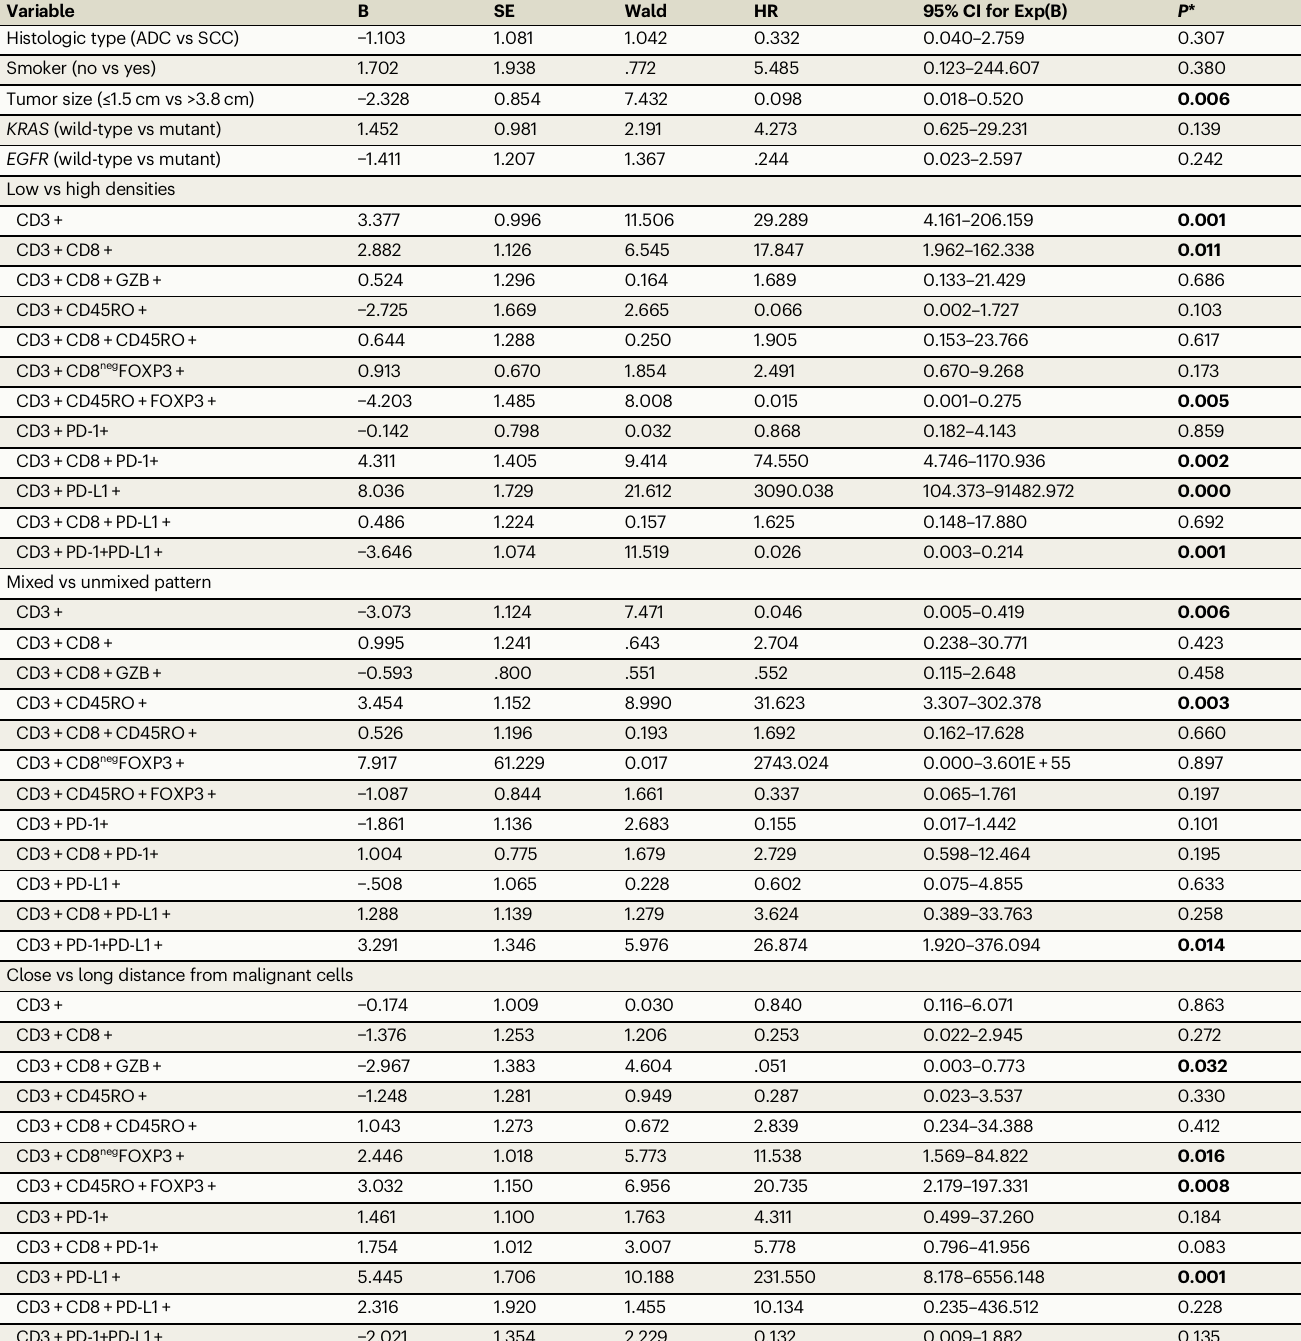
Table 4 | Cox proportional hazards regression model of overall survival in patients with non-small cell lung cancer compared high and low densities, close with long distances and mixed with unmixed pattern relative to malignant cells, adjusted for clinicopathologic